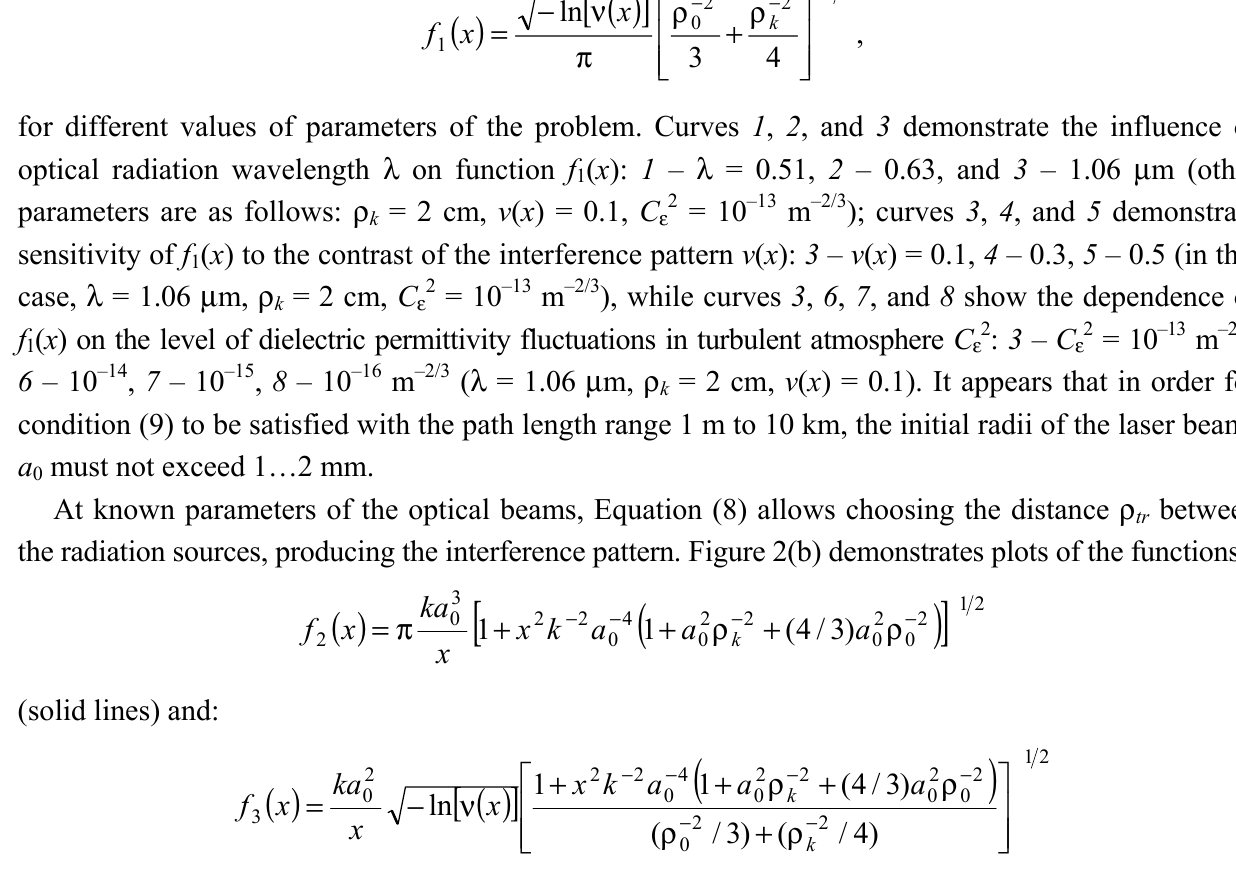
(dashed lines) calculated for different values of the parameters of the